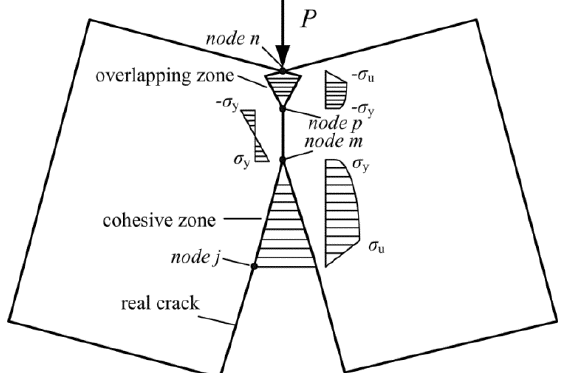
Figure 9. Nonlinear cohesive and overlapping stress distributions along the mid-span cross-section of the TPB